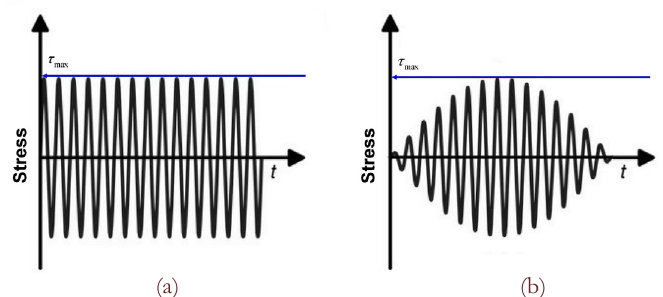
Figure 9: Two different loading paths with same maximum